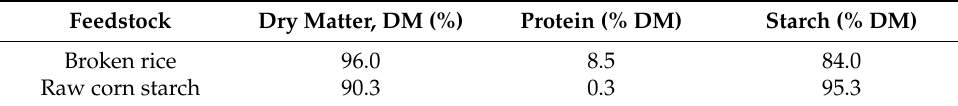
Table 4. Composition of feedstocks used in this